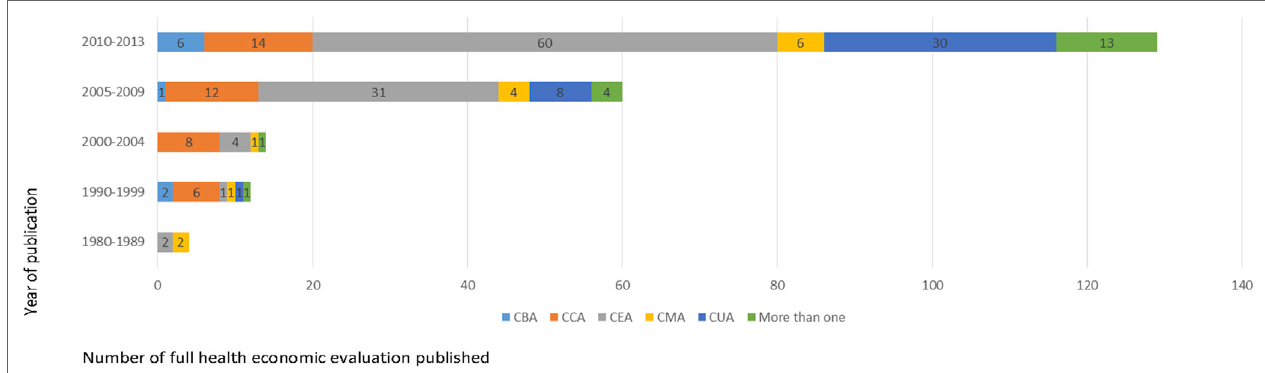
FiGURe 3 | Full health economic evaluation published in Brazil, 1980–2013. More than one: cost-effectiveness analysis (CEA) and budget impact analysis (BIA); cost-minimization analysis (CMA) and BIA; CMA, cost-benefit analysis (CBA), and cost-consequences analysis (CCA); ACU and ACB; CMA and CBA; CEA, cost-utility analysis (CUA), and